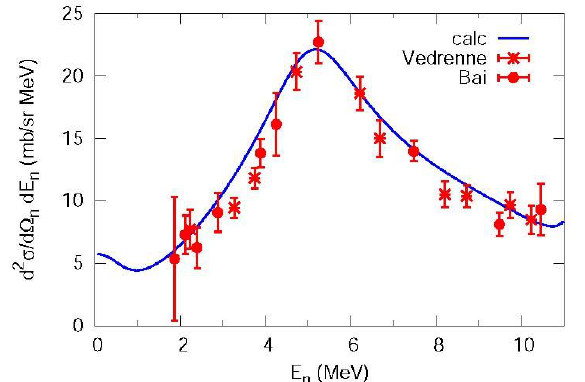
Fig. 3. The comparison between the calculated double differential cross sections and experimental data (Vedrenne [11] and Bai [12]), the incident neutron energy E n = 14.1 MeV and the secondary neutron emission angle is 15 0 .